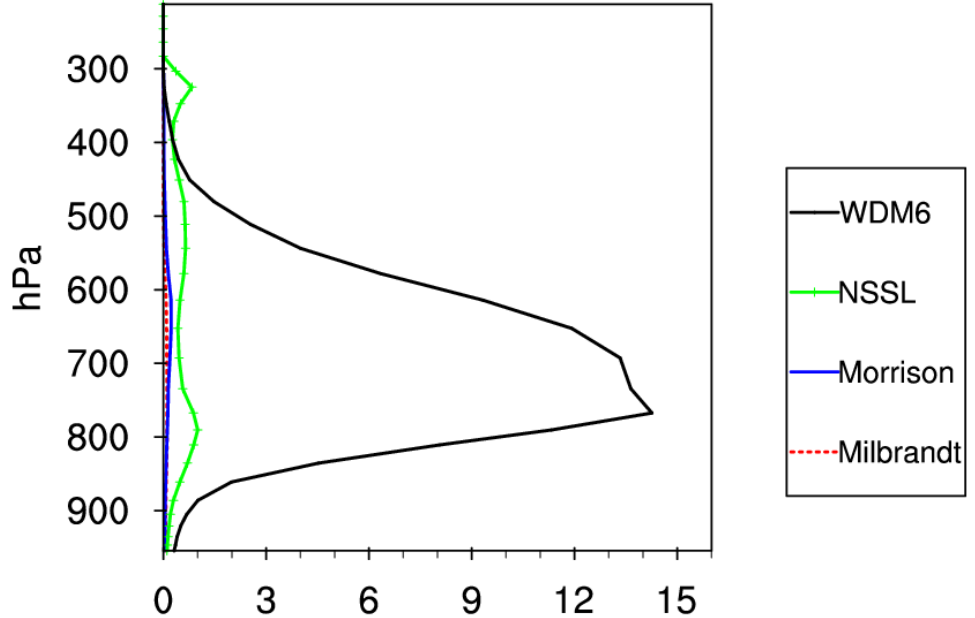
Figure 18. Vertical profiles of domain-averaged rain water number concentration (units: 10 4 kg − 1 ) with four different double − moment MP schemes at 2230 UTC 16 April 2016 in strong convective areas. (black line: WDM6, green line: NSSL, blue line: Morrison, red line: Milbrandt)